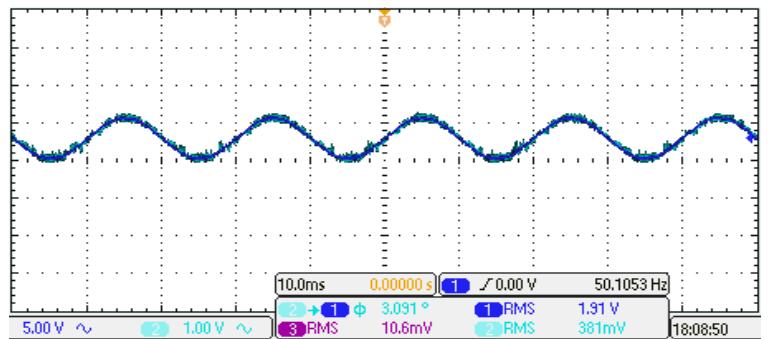
Figure 18. The 7-level inverter experimental results under grid-tied current control.